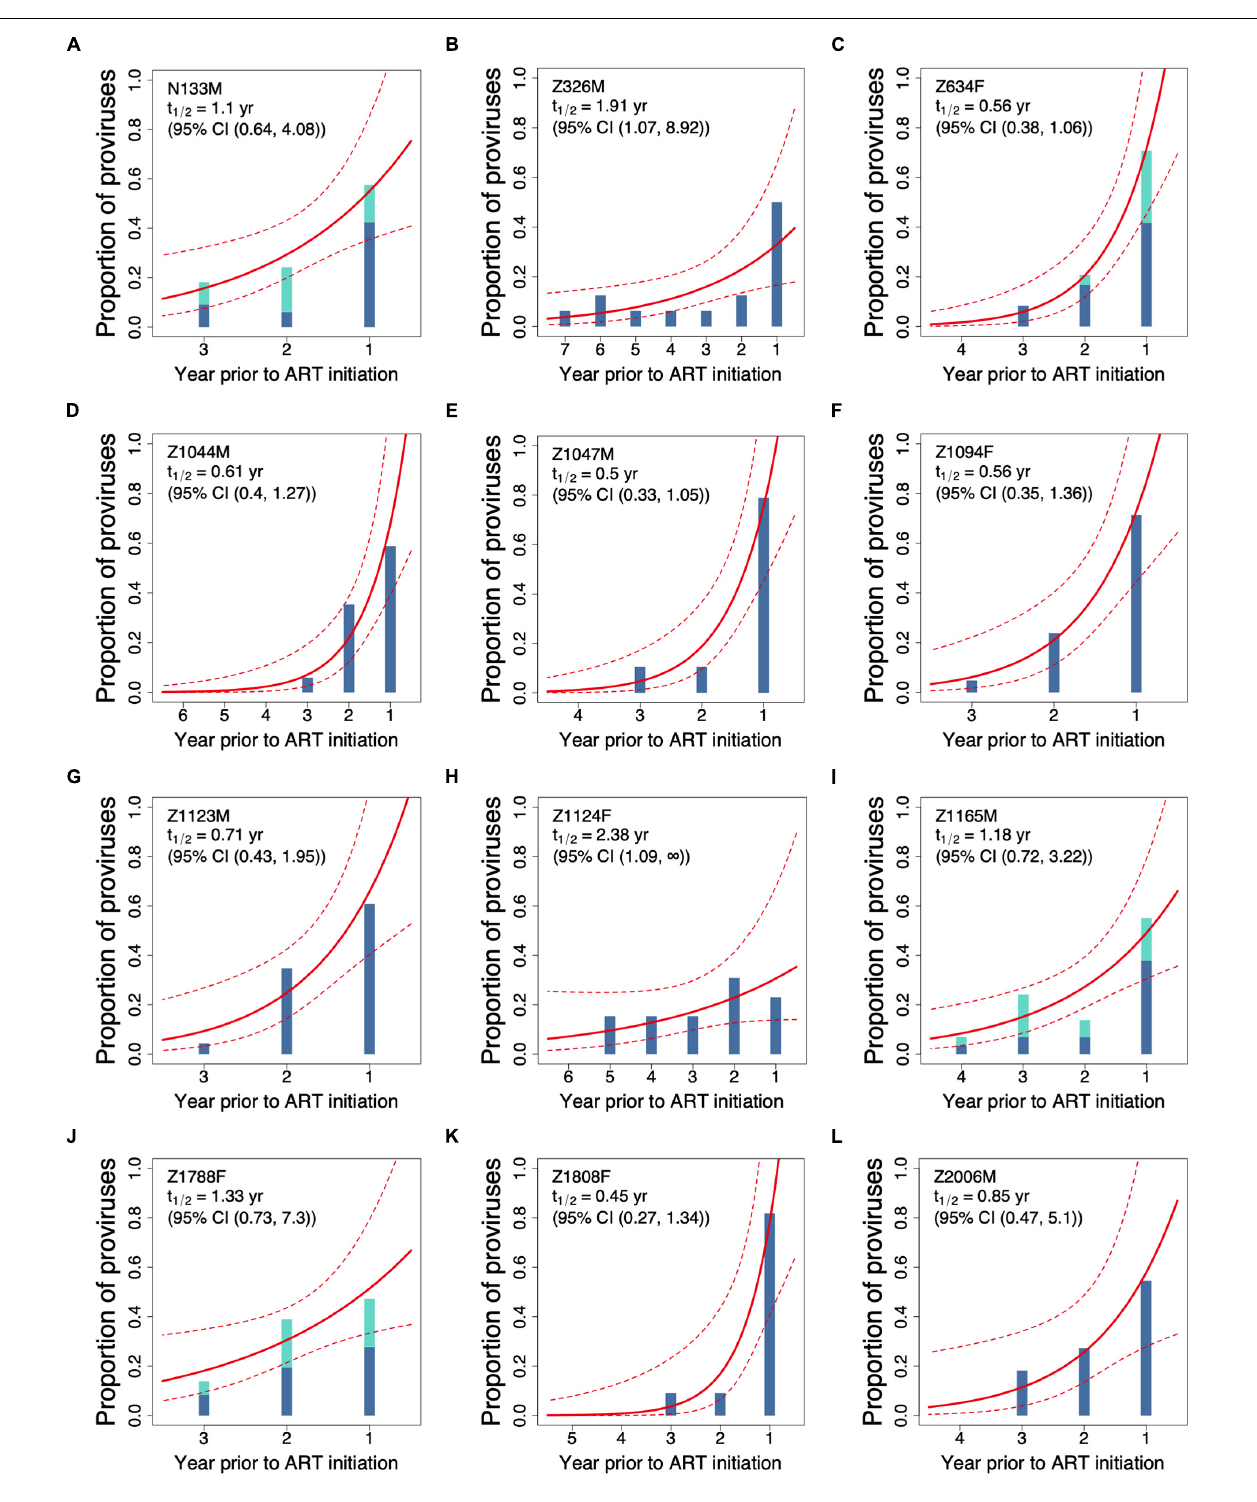
FIGURE 4 | Best-fitting proviral decay rates inferred from participants’ proviral compositions on ART (A–L) . Each participant’s proviral distribution on ART, as determined phylogenetically via the procedure outlined in Figure 2 , is depicted as histograms that show the proportions of proviruses remaining from each year of integration. For the four participants whose proviral pools were sampled twice on ART (N133M, Z634F, Z1165M, and Z1788F), proviral composition is shown as stacked bars. The solid and dashed red lines represent the best-fit half-life and associated 95% confidence intervals, respectively, estimated using a Poisson generalized linear model. Participants are sorted by study